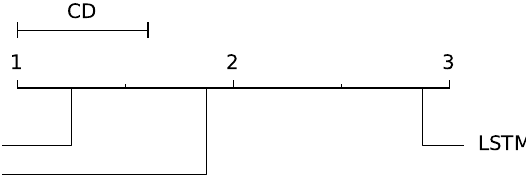
Figure 11. Critical difference diagram showing pairwise comparison of the average ranks in terms of MAE (Mean Absolute Error) ( p <